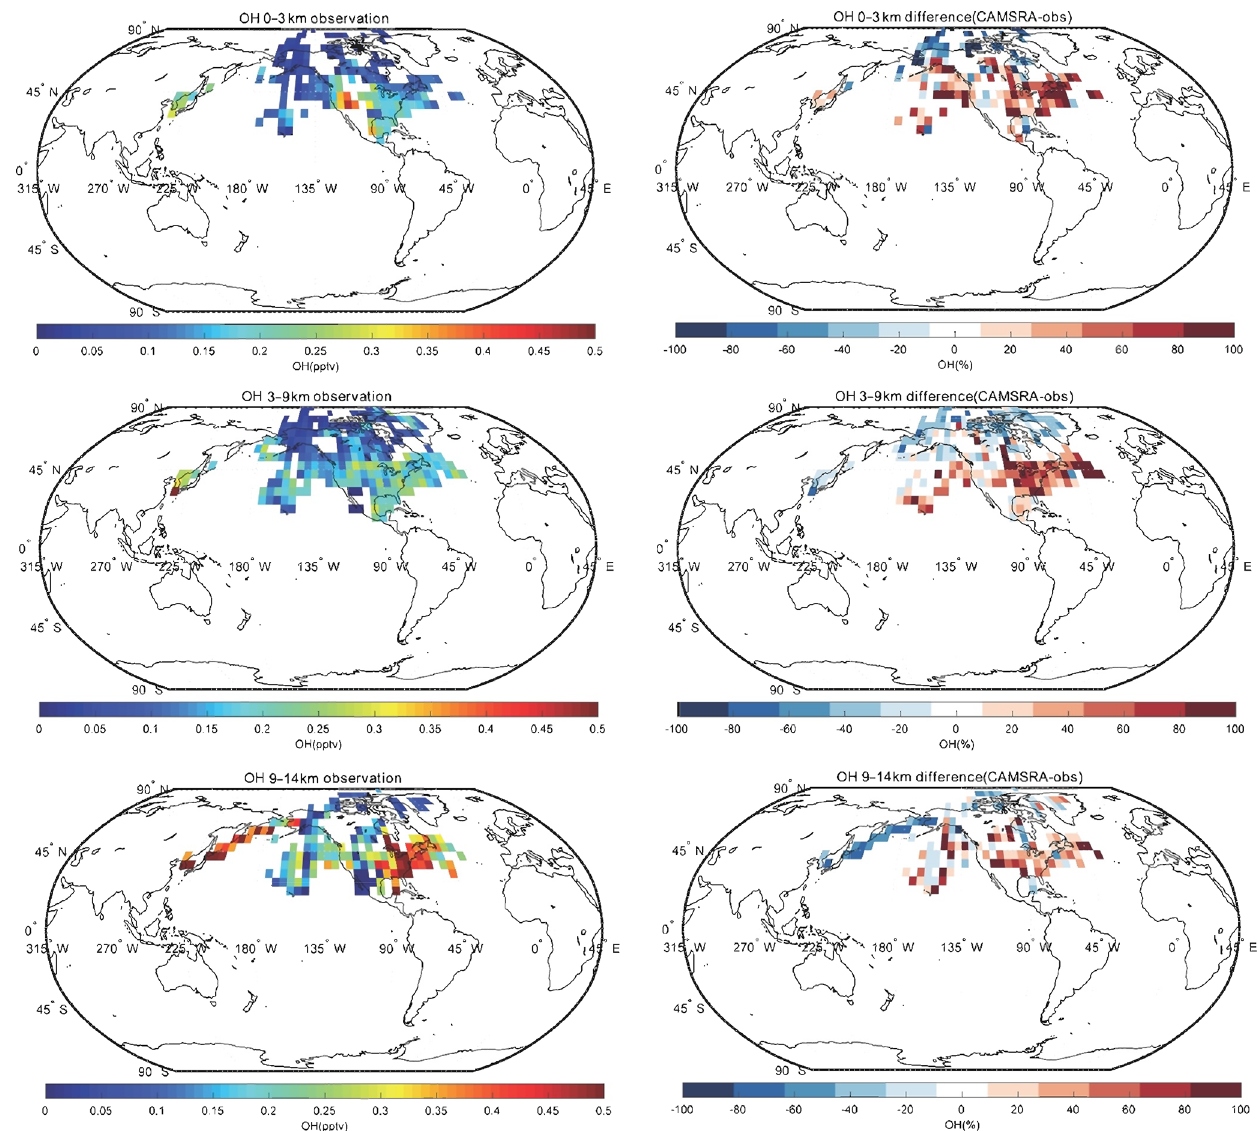
Figure A3. Same as Fig. A1, but for